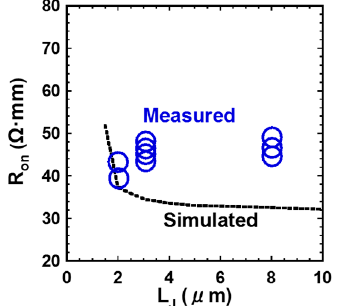
Figure 15. On-resistance as a function of JFET gap (L J ).